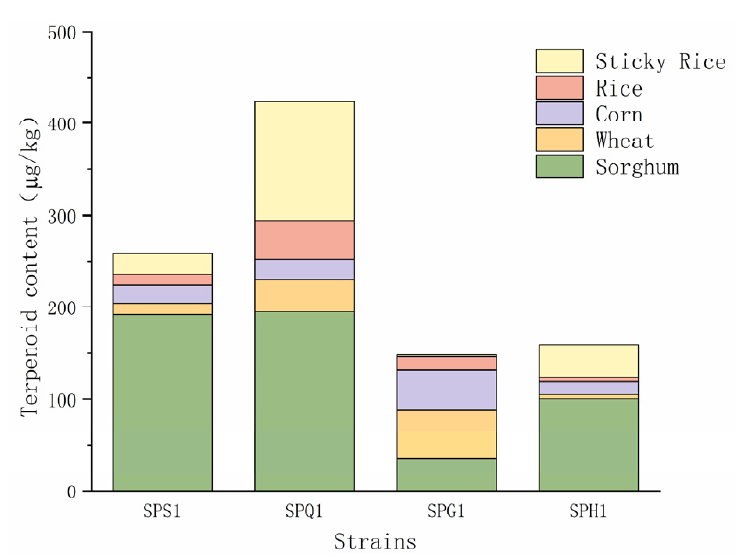
Figure 2. Content of terpenoid products from liquid-state fermentation of different strains.